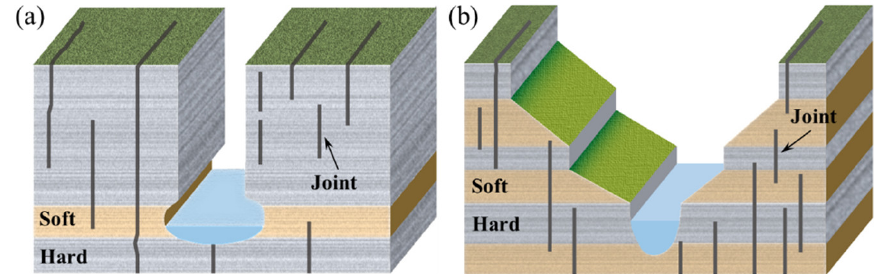
Figure 4. Stratigraphic structure characteristics in the study area. ( a ) Upper hard and lower soft strata, which are mainly distributed in Wangmang Gorge, Wuzhi Gorge, Hongdou Gorge and Baquan Gorge. ( b ) Soft-hard alternating strata, which are mainly distributed in Qinglong Gorge.